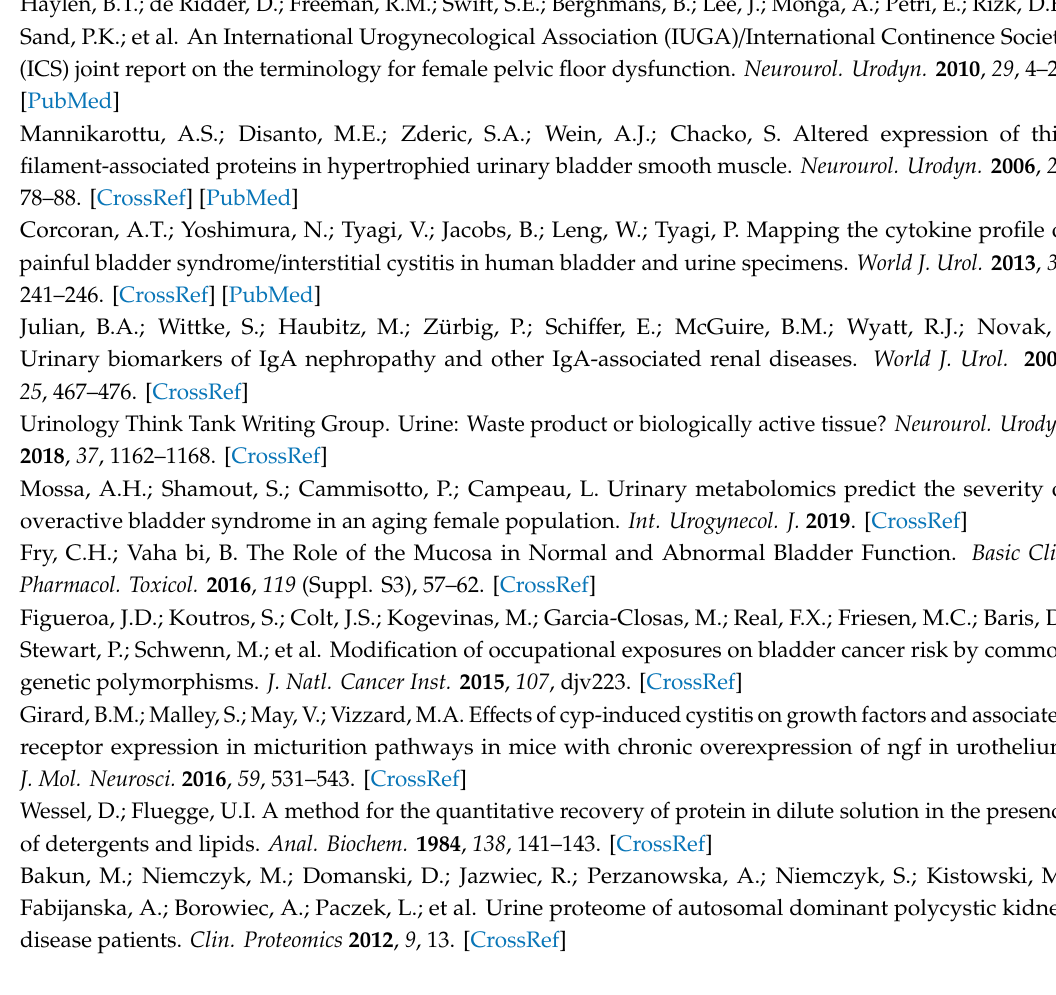
Table S1: Full list ExpOABK_01, Table S2: Full list ExpOABK_02, File S1: Detailed material and